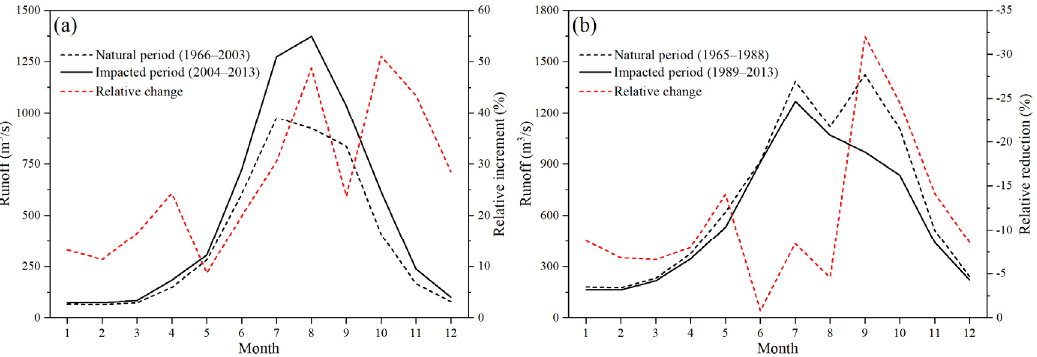
Figure 4. Average monthly runoff between the natural and impacted periods in the SRYZ ( a ) and SRYR ( b ).